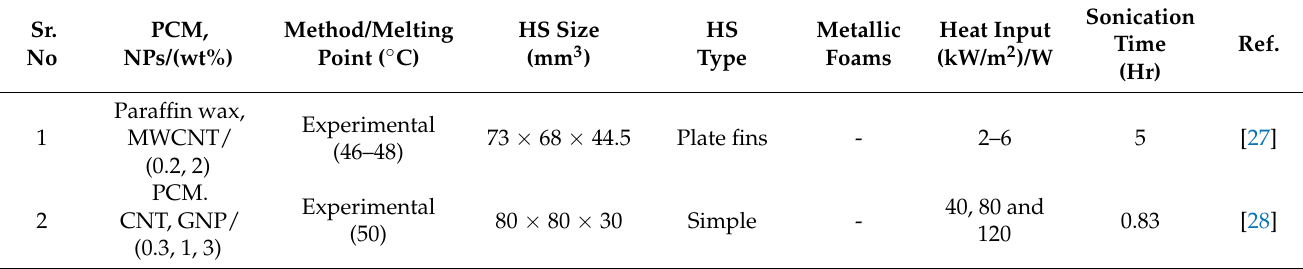
Table 1. Summary of various heat sinks used for passive cooling of electronic